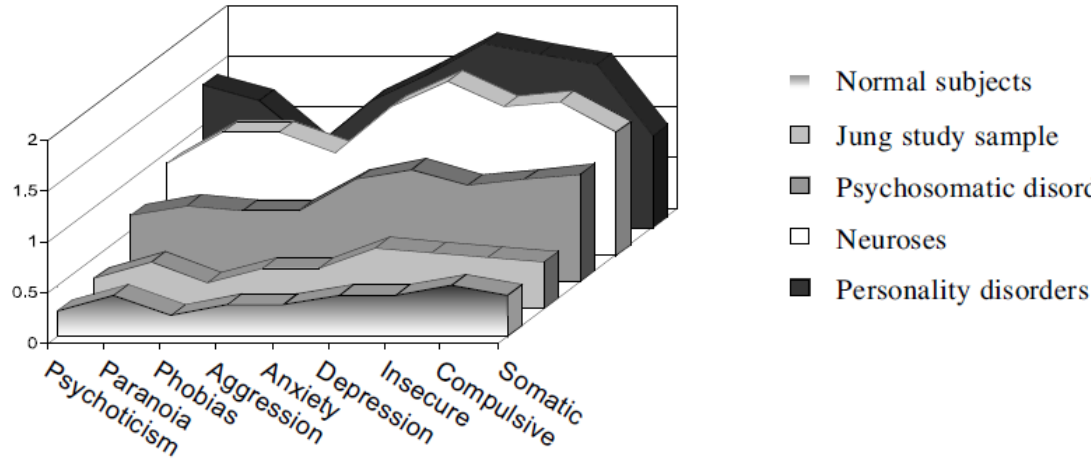
Figure 1. Mean SCL-90-R measures on follow-up compared to standardization